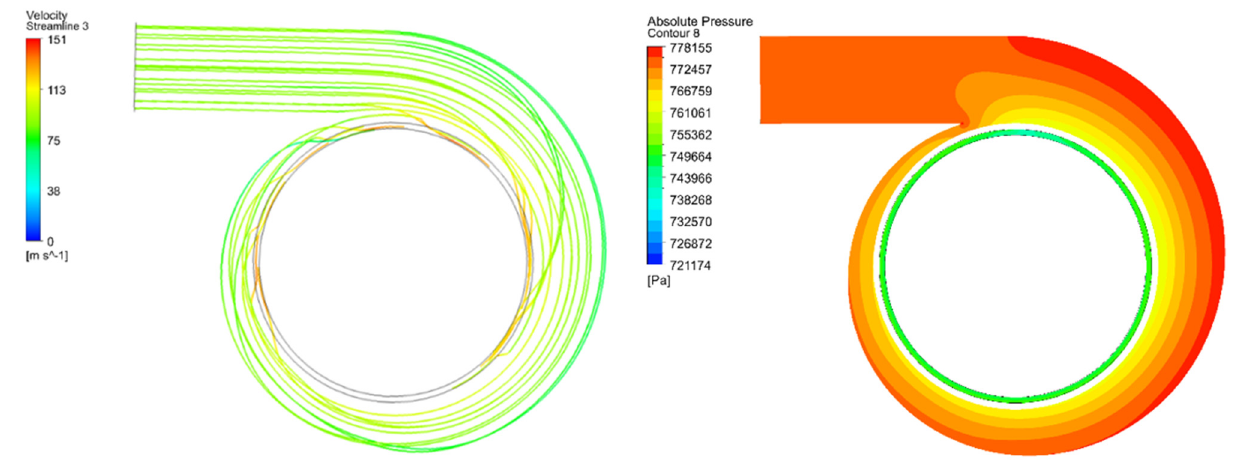
Figure 3. Streamlines and pressure field in the scroll.